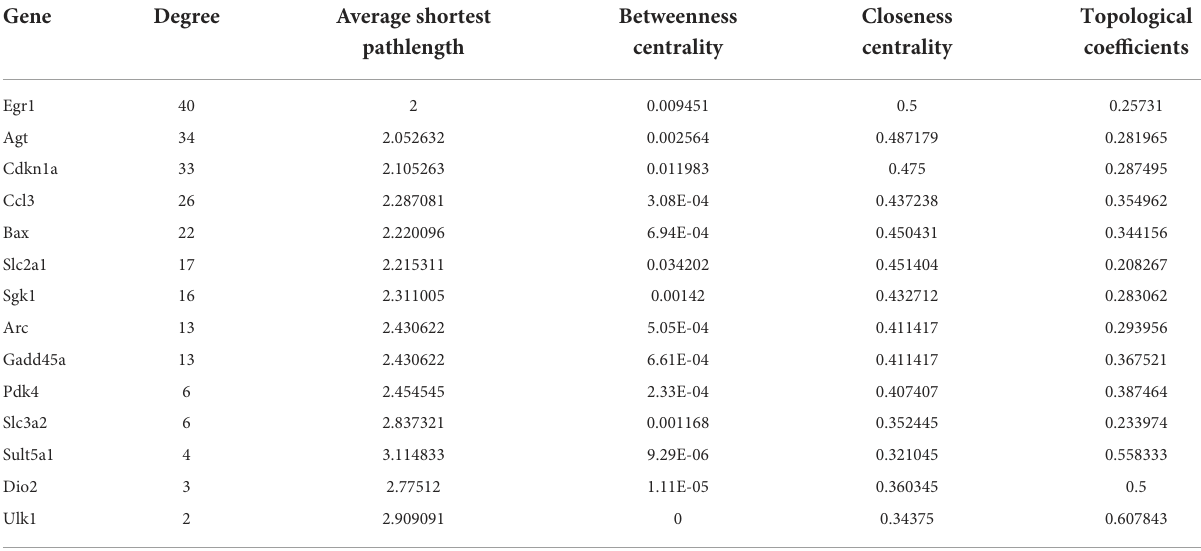
TABLE 2 The topology character of cross talk gene in PPI